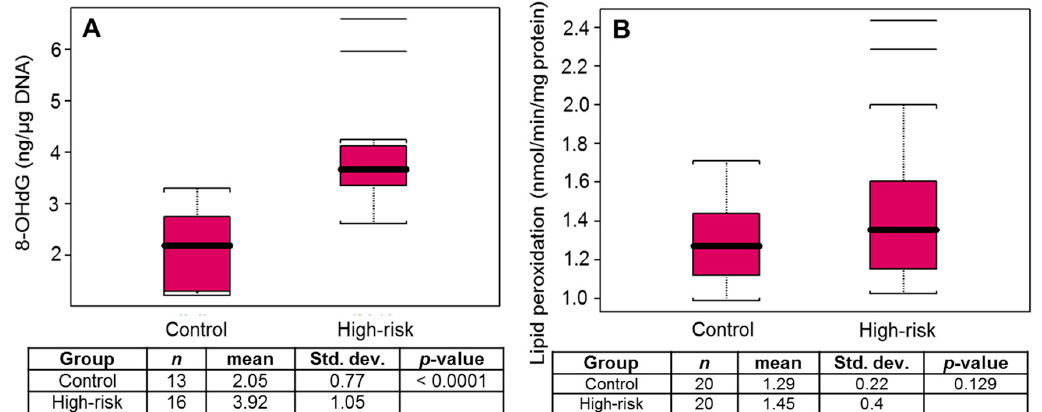
Figure 1. Box plot for ( A ) 8-OHdG and ( B ) lipid peroxidation in healthy controls and high-risk subjects for prostate cancer. Black bar = median, red box = 25th to 75th percentiles, Bars = entire range. The horizontal lines beyond the bars are outliers or whiskers are drawn individually.